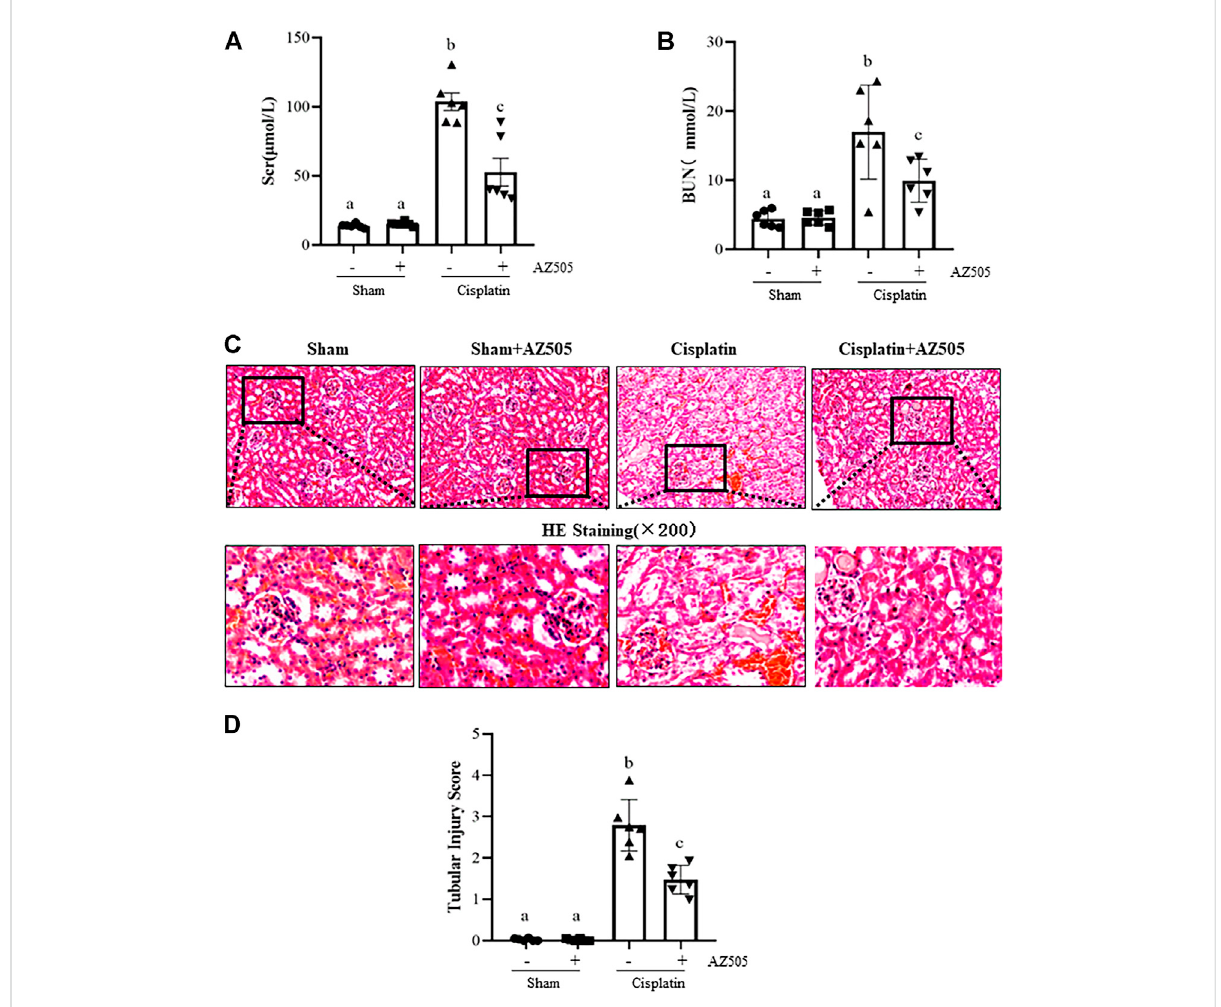
Inhibition of SMYD2 with AZ505 improves kidney function and ameliorates kidney pathological damage induced by cisplatin. (A,B) Mice blood was collected at 48h after cisplatin injection with or without AZ505 administration, Scr (A) and BUN (B) were measured by assays as indicated in the Materials and Methods. (C) Photomicrographs illustrate HE staining of the kidney tissues with or without AZ505 treatment (×200). (D) The graph shows thescores ofkidney tubular injury ineach group based on thescale described in Materials and Methods.Data are means± S.E.M. ( n = 6). Means with different superscript letters are signi fi cantly different from one another ( p <